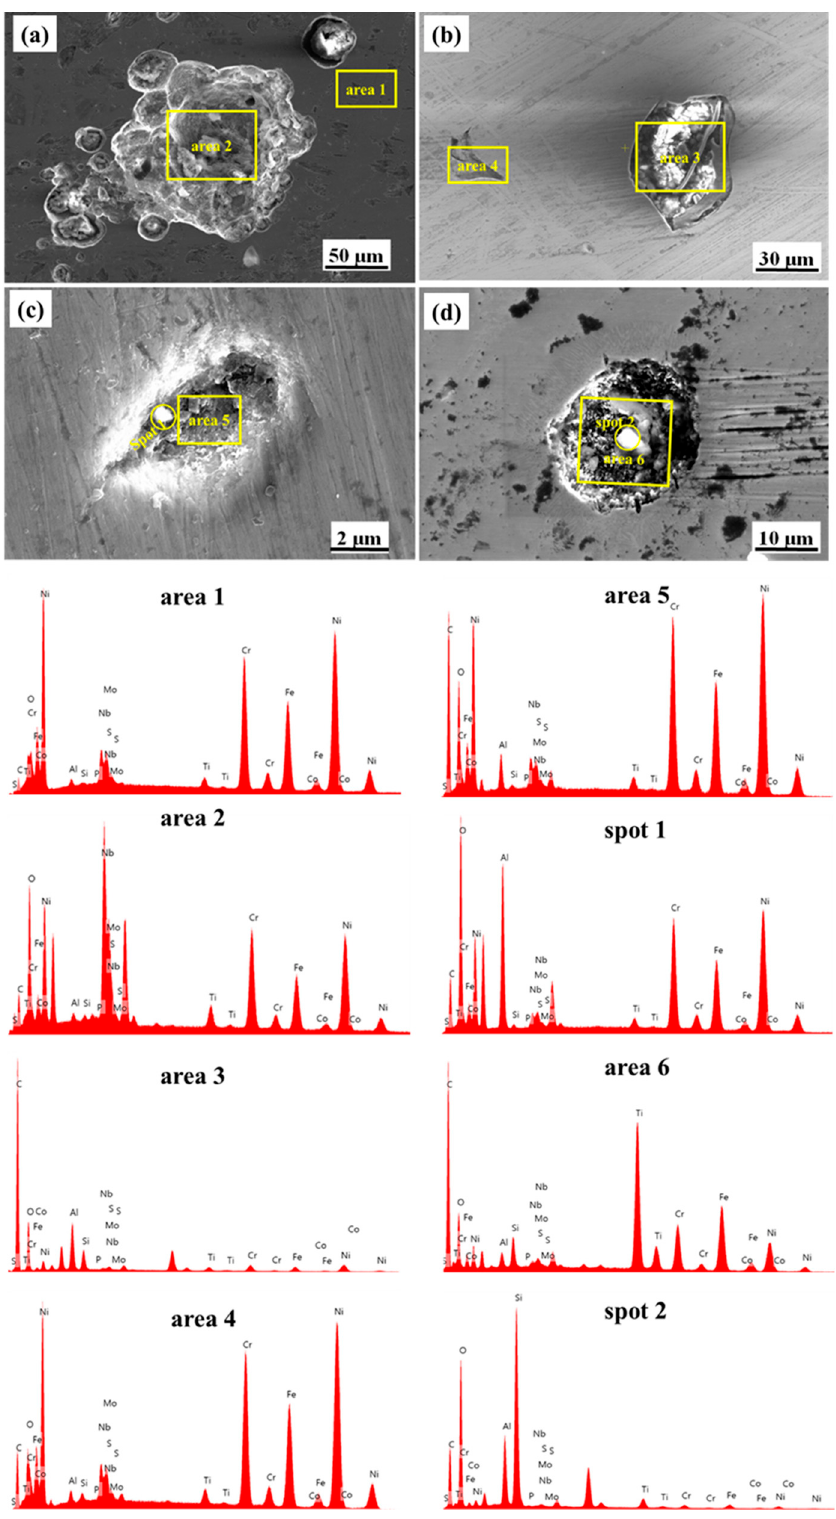
Figure 11. Energy-Dispersive Spectroscopy (EDS) analysis of pits in corroded samples: ( a ) AB, ( b ) HT, ( c ) SP, and ( d ) HTSP. The peak of the elements in corresponding areas and spots marked in yellow colors are presented, mentioning the specific areas and spots.